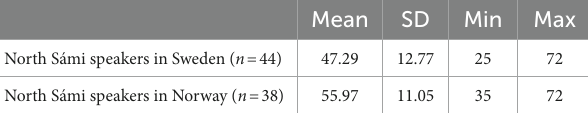
TABLE 6 Scores on Sámi vocabulary task (NSVT) in Norway and Sweden. Mean SD Min Max North Sámi speakers in Sweden ( n = 44) 47.29 12.77 North Sámi speakers in Norway ( n = 38)